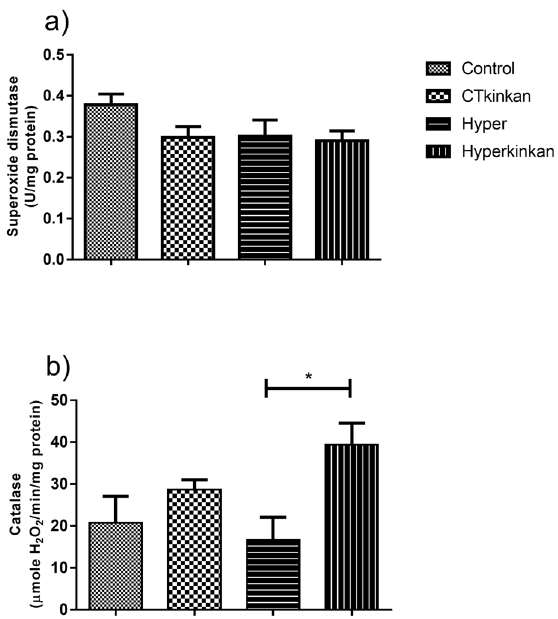
Figure 3. Effect of kinkan orange intake on hepatic (a) superoxide dismutase (SOD) and (b) catalase activities of rats given Control, CTkinkan, Hyper, and Hyperkinkan diets. The data represents means + SEM of 10 animals per group. *p < 0.05. *Bars represent statistical significance, p < 0.05, using two-way ANOVA followed by post hoc Bonferroni